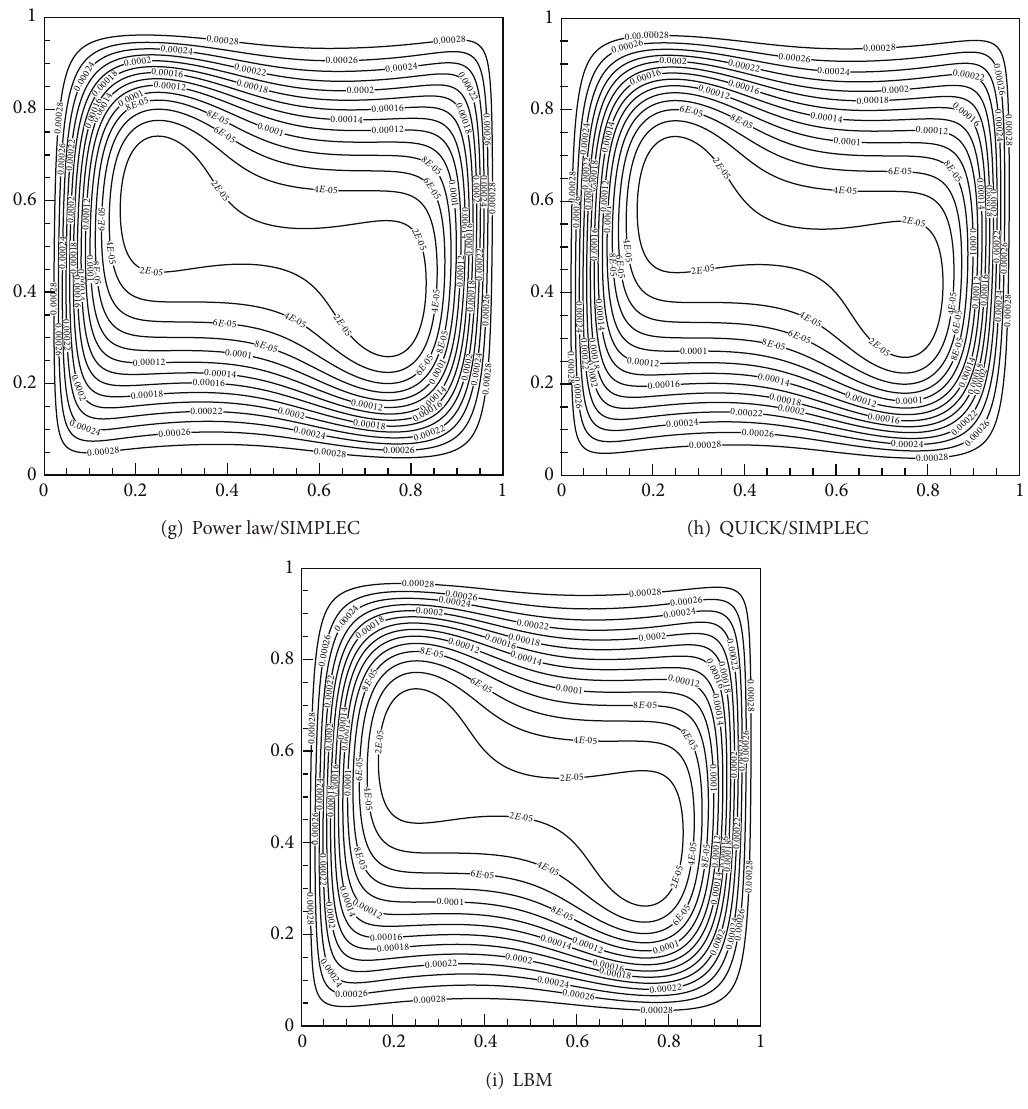
Figure 4: Streamlines contours.